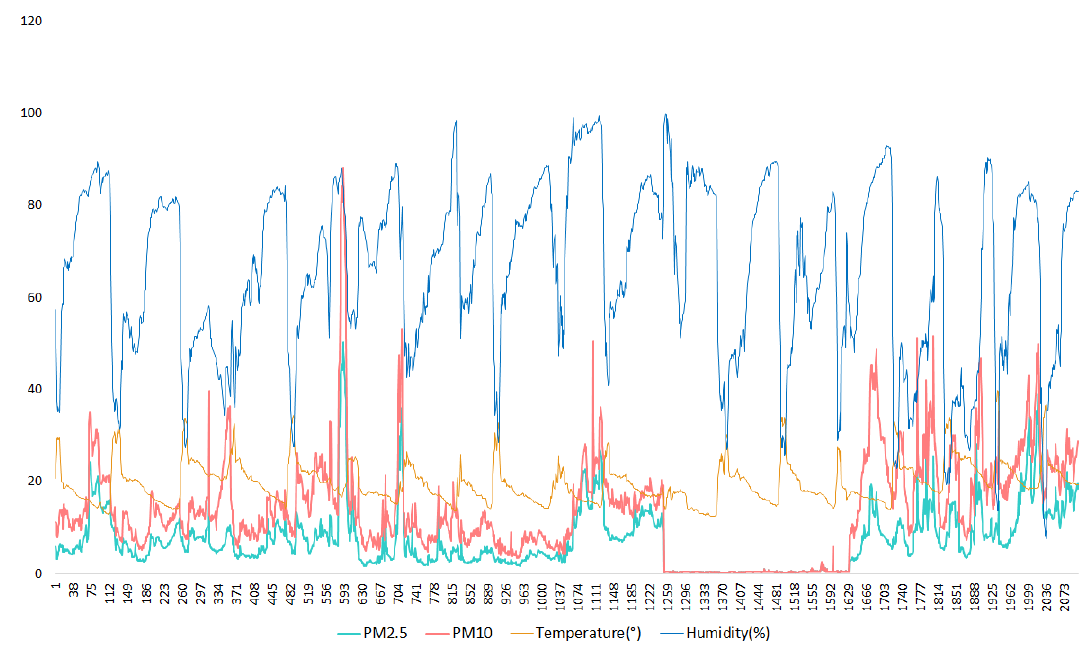
Figure 13. PM concentrations in µ g/m 3 , recorded by a nomadic sensor in Hay Nahda I.